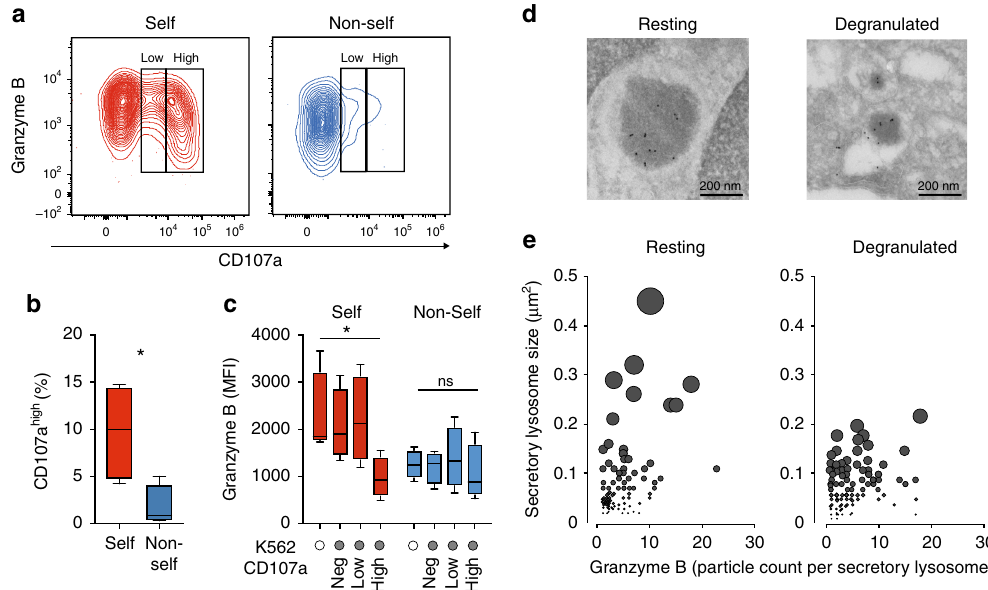
Fig. 4 Educated NK cells mobilize dense-core secretory lysosomes. a Representative example of granzyme B and CD107a expression in self KIR + and non- self KIR + CD56 dim NKG2A − NKG2C − CD57 − NK cells following stimulation with K562 cells. b Aggregated data of percent CD107a high NK cells following stimulation with K562 cells ( n = 5 donors). c Expression of granzyme B in the indicated NK cell subset after stimulation with K562. Summary of data from 4 C1/C1 donors. d Representative images of immuno-EM sections of resting (left) or sorted degranulated CD107a high NK cells (right). Scale bar: 200 nm. e Secretory lysosome size and granzyme B content as determined by immuno-EM in resting and sorted CD107a high NK cells after stimulation with K562. A Wilcoxon test was performed in panel ( b ). A non-parametric Friedman test was performed in panel ( c ). Whiskers show 5th to 95th percentile. Bars show the median. * p < 0.05. Red and blue box plots represent NK cells with self or non-self KIR, (Fig. 3e, f and Supplementary Figure 8), suggesting that NK cell